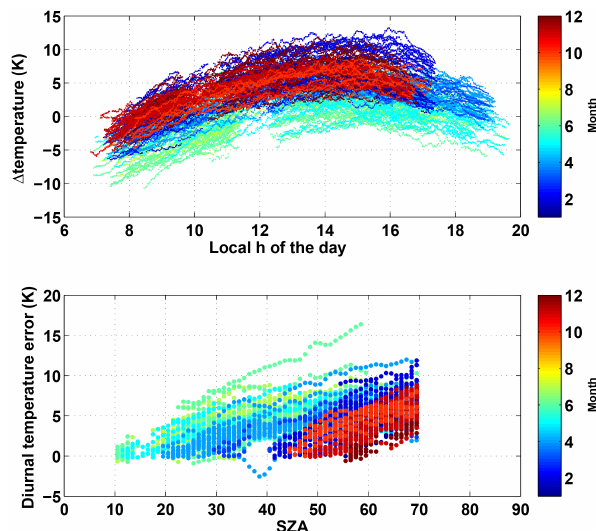
Figure B1. This figure shows the change in surface temperature throughout the day from the noontime a priori value (top panel) and the diurnal surface temperature error in the bottom panel. The diur- nal surface temperature error is computed by subtracting morning from afternoon surface temperatures in the same way as the trace gas anomalies are computed.